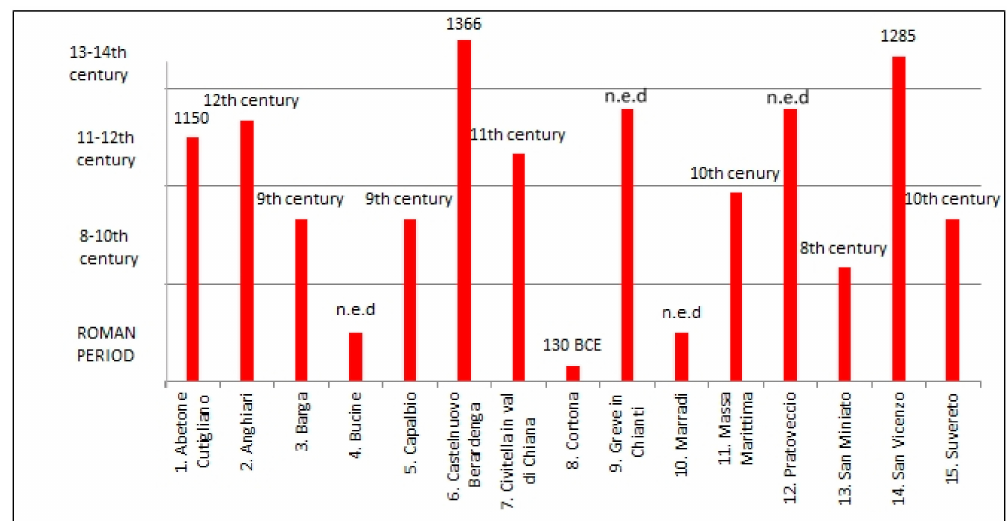
Figure 2. Founding dates of Tuscan towns. Source: own elaboration based on the data published by the Italian National Institute of Statistics [61] and Atlante Storico Iconografico Delle Citt à Toscane [62]. Key: n.e.d—no exact data available.